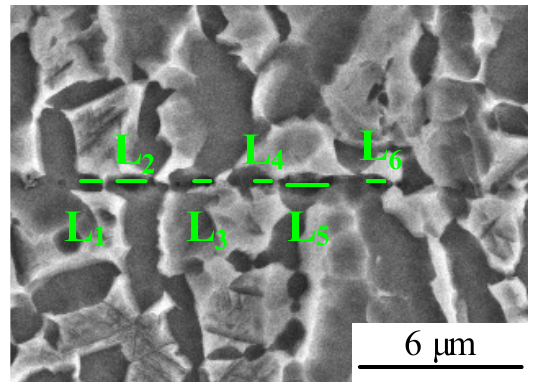
Figure 3. Schematic diagram for measuring the void size.